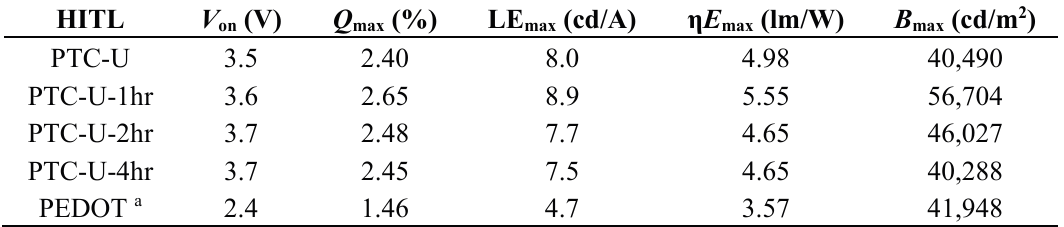
Figure 5. I – V characteristics of hole-only devices. Table 1. EL Data for Devices Having the Structure ITO/HITL/NPB/Alq 3